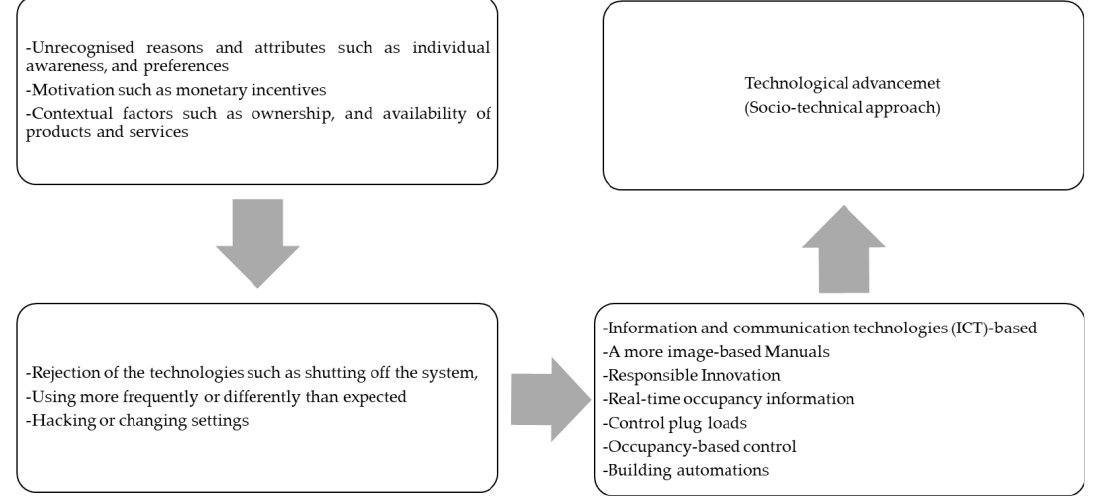
Figure 3. The contextual and technology gaps related to the occupants’ behaviours in EER [106- 109].